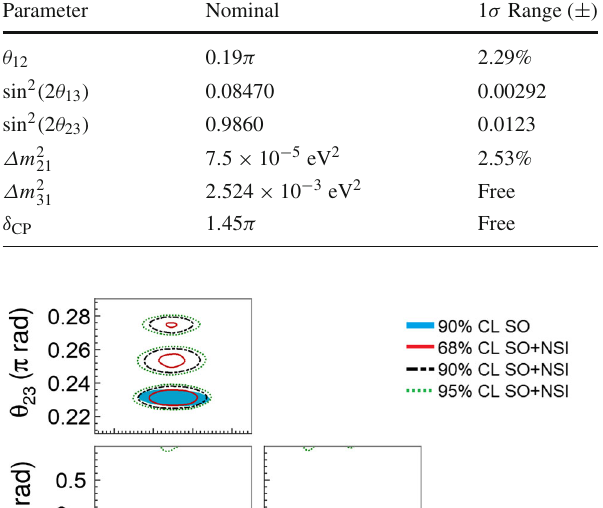
blue filled areas we assume only standard oscillation. In the regions delimited by the red, black dashed, and green dotted lines we constrain standard oscillation parameters allowing NSI to vary